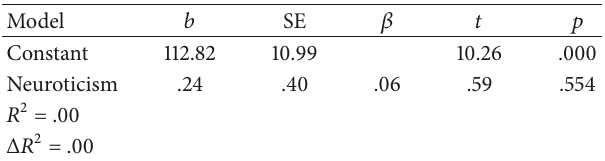
Table 2: Reliability analysis of Schutte Emotional Intelligence Scale (SEIS) and Big Five Inventory (BFI) ( 𝑁 = 100 ).